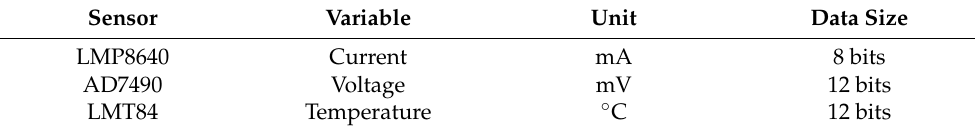
Table 1. Descriptions of solar panel sensors.